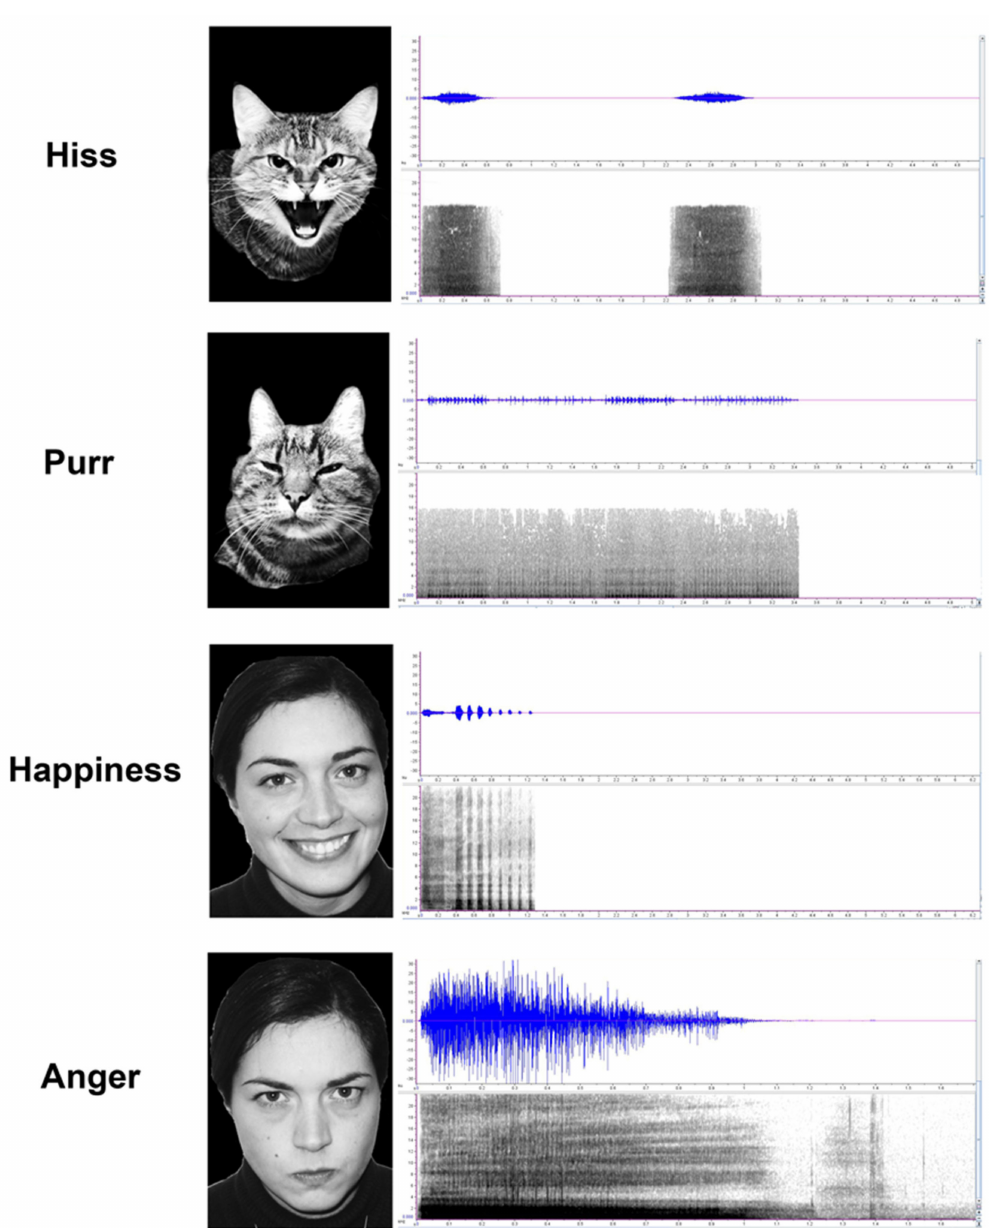
Figure 1. Examples of faces and their corresponding vocalizations used in the cross-modal paradigm (“human-anger” vs “happiness”; “cat-hiss” vs “purr”). Sonograms show the di ff erent emotional vocalizations (time in seconds, frequency measured in